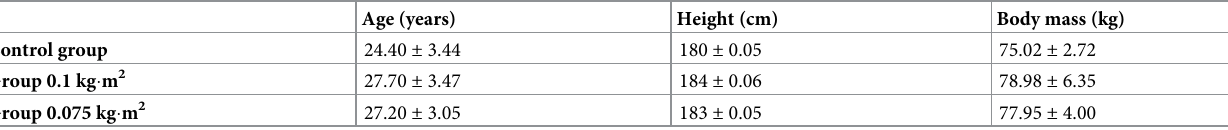
Table 1. Individual physical characteristics of control and experimental groups. Data: Mean ± SD.